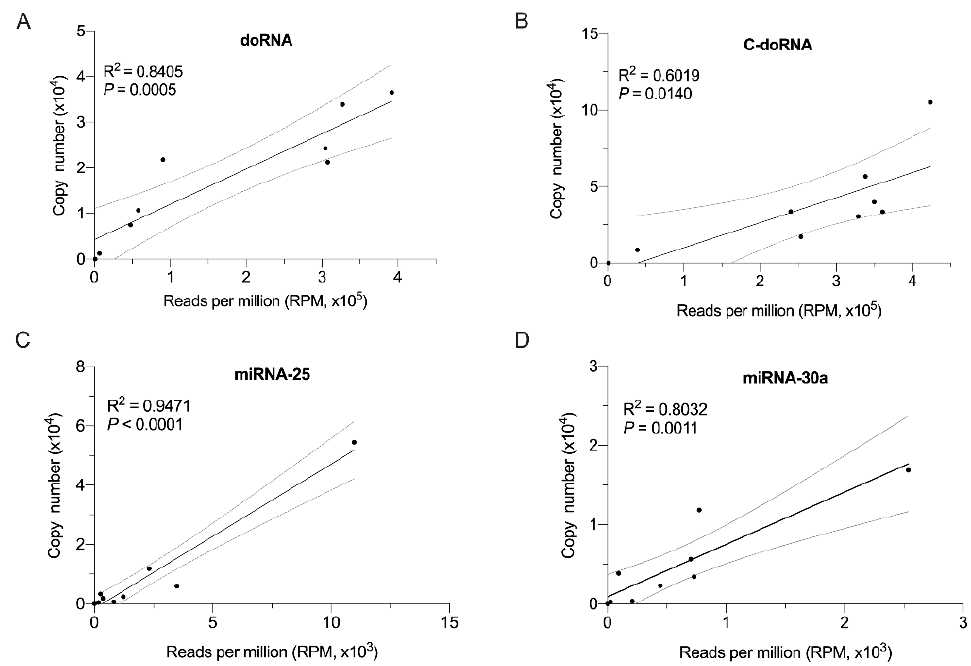
Figure 7. Splinted 5 (cid:48) ligation RT-qPCR validation of small RNA-Seq data. Correlation between the relative abundance of doRNA ( A ), C-doRNA ( B ), miR-25 ( C ) and miR-30a ( D ) assessed by splinted 5 (cid:48) ligation RT-qPCR or small RNA-Seq. qPCR data are represented as the average copy number from 3 technical replicates, while small RNA-Seq data are represented as the number of reads per million for one replicate. Linear models were used to plot the line of best fit for each correlation with confidence of 95%; the R 2 value of the correlation is indicated.